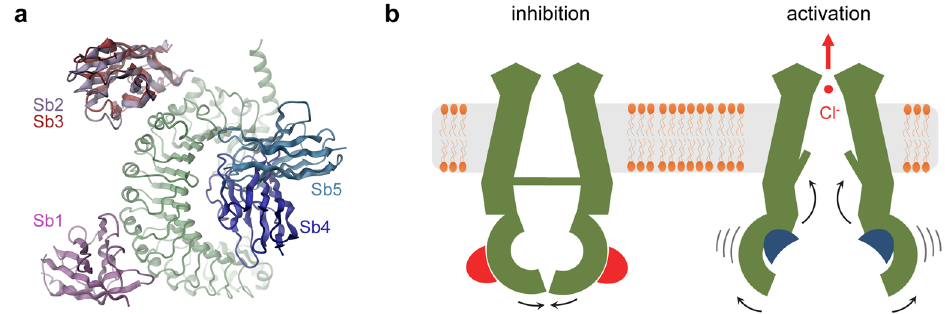
Fig. 8 Potential mechanisms. a Location of sybody binding sites on the LRR domain of LRRC8A. The proteins are shown as ribbon with different sybodies labeled. b Schematic depiction of a potential modulatory mechanism of channel function by sybody binding. Binding of inhibitory sybodies to the convex outside of the LRR domains (left) reduces fl exibility of the domains, which stabilizes a closed channel conformation. Conversely, the binding of activating sybodies to the concave inside increases domain mobility, which is in some way transmitted to the pore region to open the ion conduction